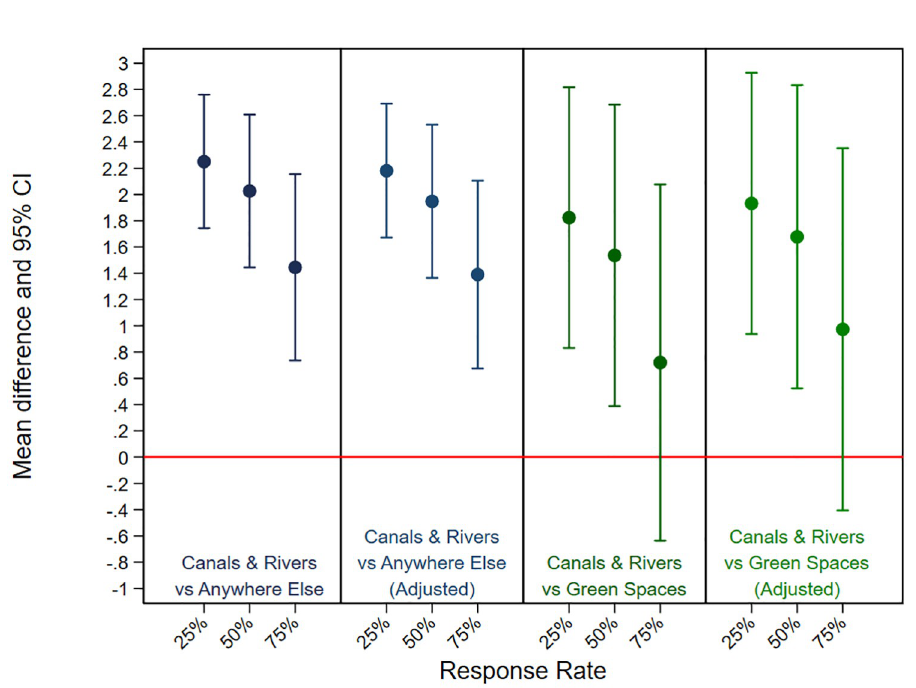
Fig 2. Higher mental wellbeing for visiting canals and rivers compared to being anywhere else and being in other green spaces. Adjusted for age, gender, ethnicity, and level of education. Error bars represent 95% Confidence